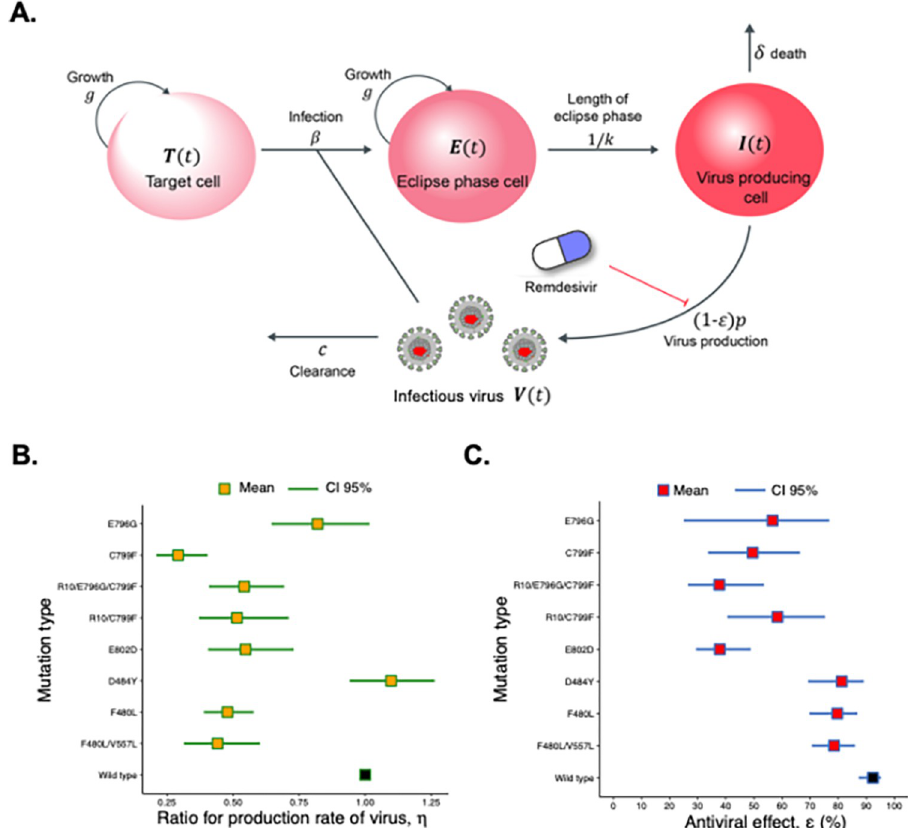
Fig 3. Quantifying antiviral effects of RDV against SARS-CoV-2 infection. (A) Schematic diagram of SARS-CoV-2 infection under RDV treatment in cell culture. The target cells are infected by infectious virus at rate β and become eclipse phase cells. The average duration of the eclipse phase is 1 / k days and these eclipse phase cells start producing viruses at rate p (i.e., become virus-producing cells). The target cells and eclipse phase cells are assumed to divide at rate g , and virus-producing cells die at rate δ . Progeny infectious viruses are cleared at rate c . RDV blocks virus production by inhibiting viral replication in infected cells with inhibition rate ε . (B) Comparison of the fold-change of virus production rate, η , for eight different RDV-resistant viruses and WT virus. Orange dots are the mean value and green lines show 95% CI, which were estimated from the experiments with/without RDV. For WT, we consider η = 1 , shown by the black dot. (C) Comparison of the antiviral effect of RDV, ε , for eight different RDV-resistant viruses and WT virus. Red and black dots are the mean values of the antiviral effects and blue lines show 95% CI, which were estimated from infection experiments with/without